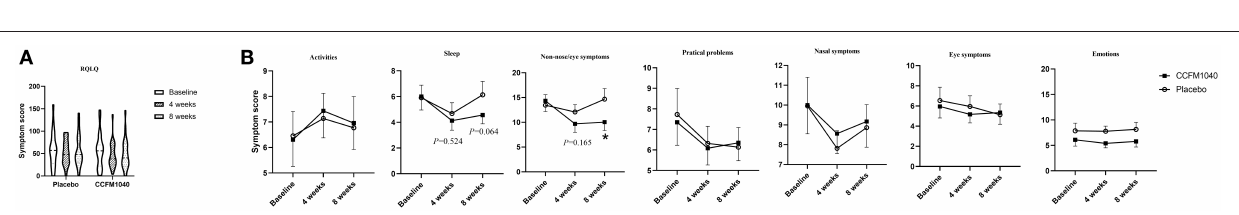
FIGURE 3 | QoL of AR in CCFM1040 and placebo groups during the study period. Results in RQLQ (A) and subgroup QoL scores (B) . Data are expressed as mean (SEM). The differences between the groups were compared using the t -test. RQLQ, sleep, non-nose/eye symptom, and eye symptoms are based on the analysis of covariance (ANCOVA), with the midpoint and the end results as the dependent variables, group as the fixed factors, and baseline as the covariates; P -values are from the two-sided test at a 5% level vs. placebo. AR, allergic rhinitis; QoL, quality of life; RQLQ, Rhinoconjunctivitis Quality of Life